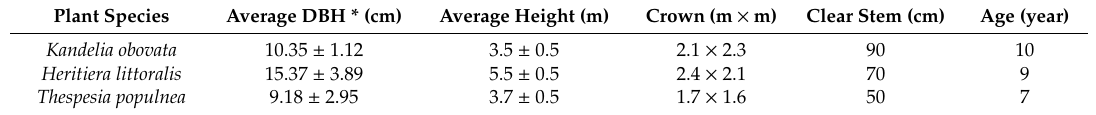
Table 1. The basic growth characteristics of the investigated mangrove trees. Plant Species Average DBH * (cm) Average Height